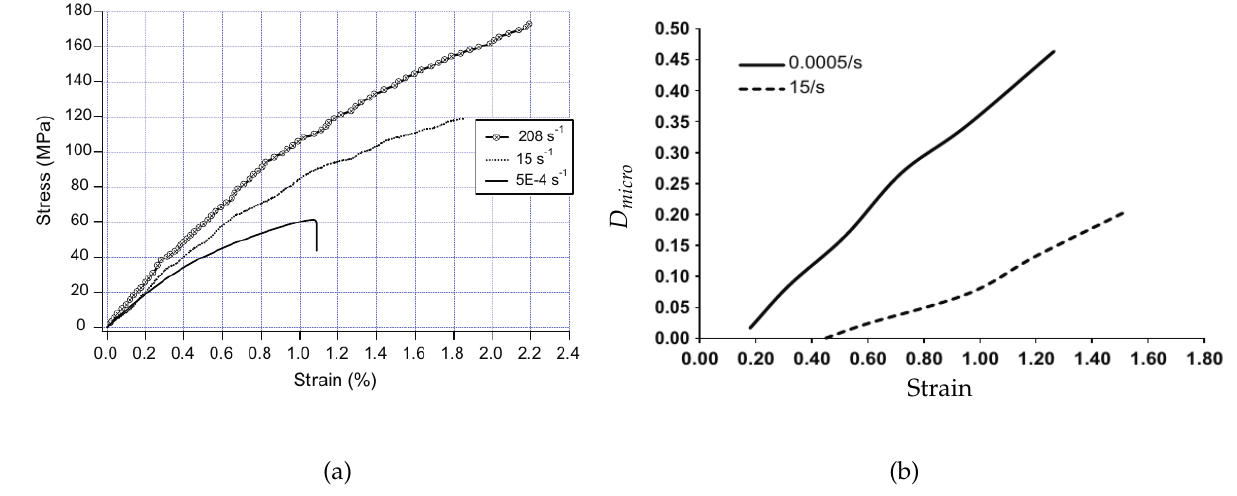
Figure 14. ( a ) Typical EPC matrix composite stress–strain tensile curves. The three characteristic stages can be shown for all strain rates; ( b ) Comparison between dynamic and quasi-static damage kinetic at the microscopic scale for all fiber orientations considered as an overall microscopic damage indicator